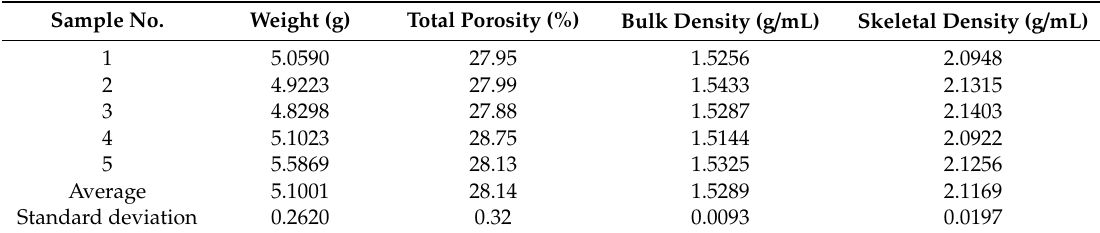
Table 2. Data of five replicates for OPC paste (w / b = 0.5, 28 days) by PDC-MIP.